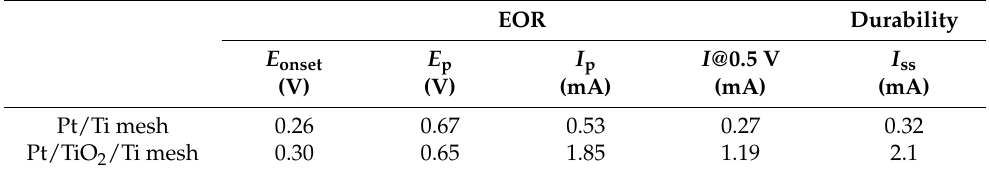
Table 3. Comparative main electrochemical performance